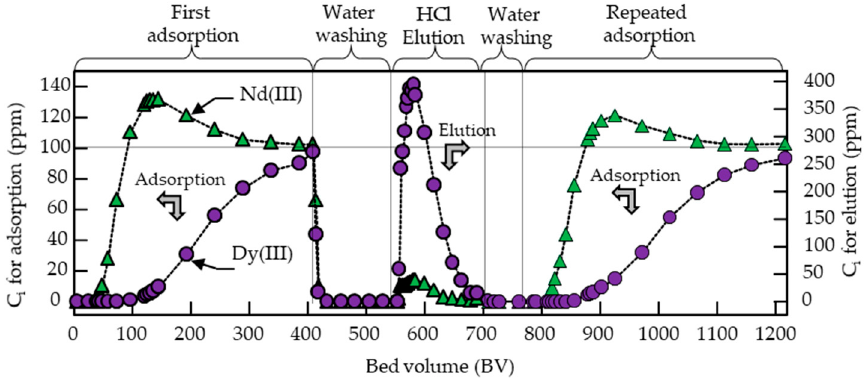
Figure 5. Profile of the adsorption and elution of Dy (III) and Nd (III) ions with an OMA-adsorbent. Adsorption solution: 100 ppm Dy (III) and 100 ppm Nd (III), pH 2.0; elution solution: 1.0 M HCl; space velocity (SV) = 100 h –1 ; temperature = 25 °C; the total 1200 BV means that the adsorption–elution– adsorption process was operated for 12 h under the fixed space velocity of 100 h –1 .